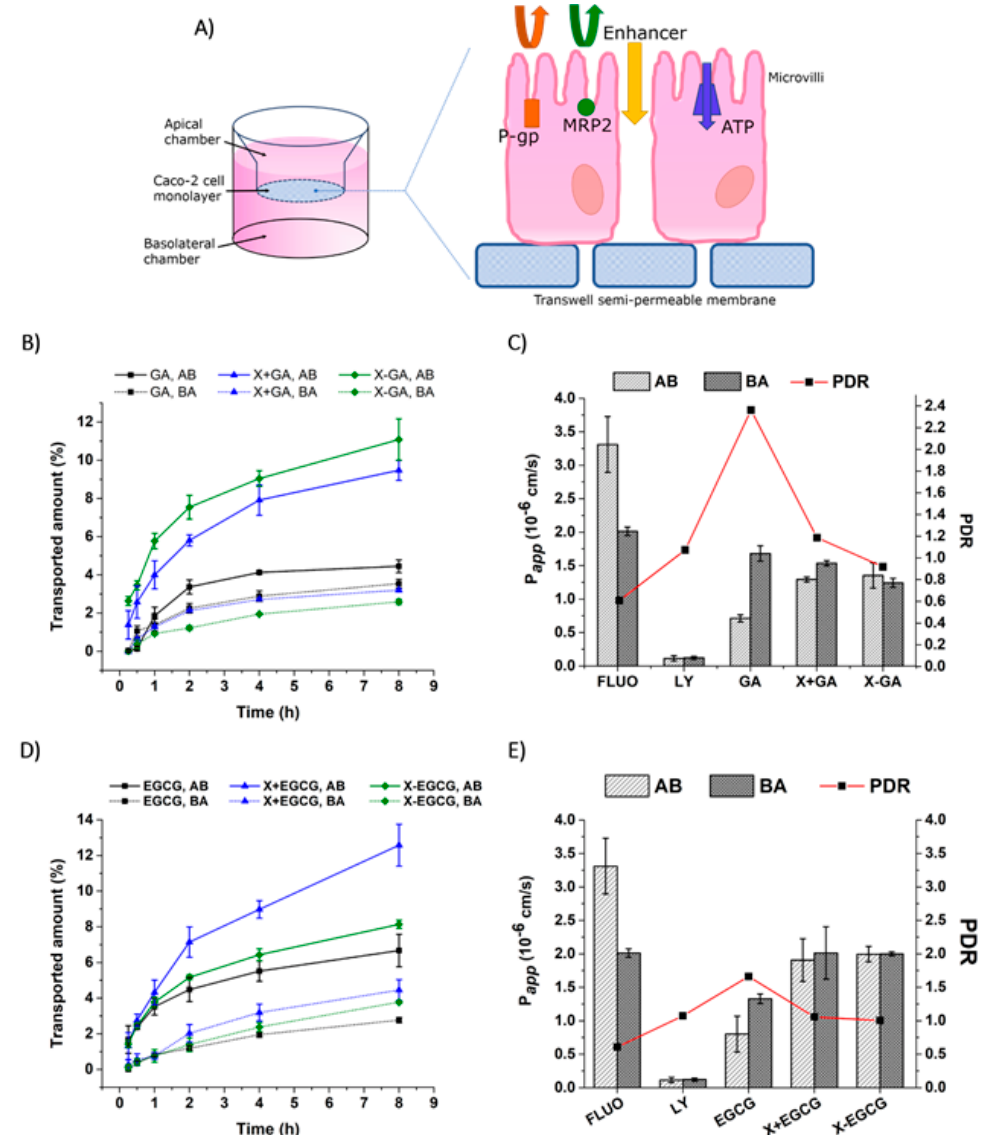
Figure 7. Transepithelial transport of GA and EGCG across Caco-2 monolayers. Illustration of the efflux transporters expressed on the apical membrane of epithelial cells ( A ). Transported amount of GA, X + GA, and X-GA ( B ), and EGCG, X + EGCG, and X-EGCG ( D ) in both AB and BA directions. Apparent permeability coefficient, P app , and PDR of GA, X + GA and X-GA ( C ), and EGCG, X + EGCG, and X-EGCG ( E ). All data were the mean ± SD of three independent experiments.